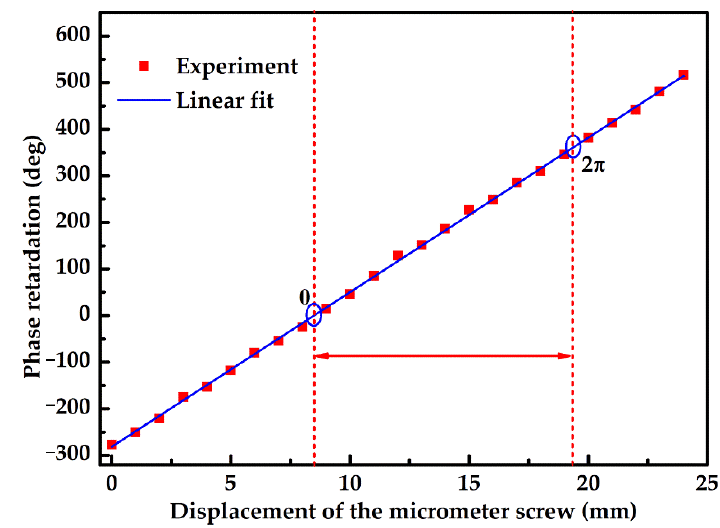
Figure 8. Phase retardation variation versus displacement of micrometer screw.